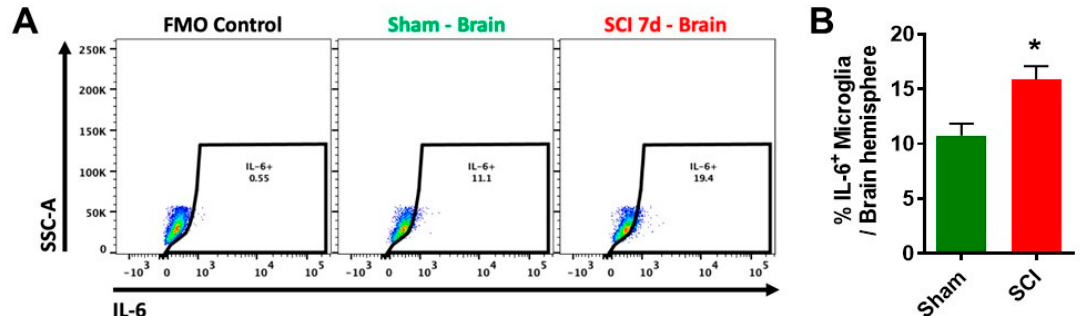
Figure 2. Increased proinflammatory cytokine IL6 + microglia occur in the brain after SCI. A T10 spinal cord contusion injury (moderate / severe injury) was produced in young adult C57BL / 6 male mice (2–3 months old) using the Infinite Horizon spinal cord impactor as previously described [38,40]. At seven days after injury, mice were perfused with ice-cold PBS, and the brain hemisphere was isolated for preparation of single cell suspension using standard FACS protocol. Cells were then incubated with Fc Block prior to staining with primary antibody-conjugated fluorophores: CD45-Bv421, CD11b-APC / FireTM750, and Zombie AquaTM viability dye. Cells were then subject to fixation / permeabilization for cytokine labeling (i.e., IL-6-PE). All reagents were obtained from BioLegend Inc. ( A ) A representative histogram shows the relative frequency of IL-6-positive brain-resident microglia at seven days after sham and SCI surgery. FMO: fluorescence minus one; SSC-A: side scatter-area. ( B ) The percentage of IL6-positive brain microglia is quantified. N = 4 (Sham) and 5 (SCI) mice. * p < 0.05 vs. Sham with Mann–Whitney